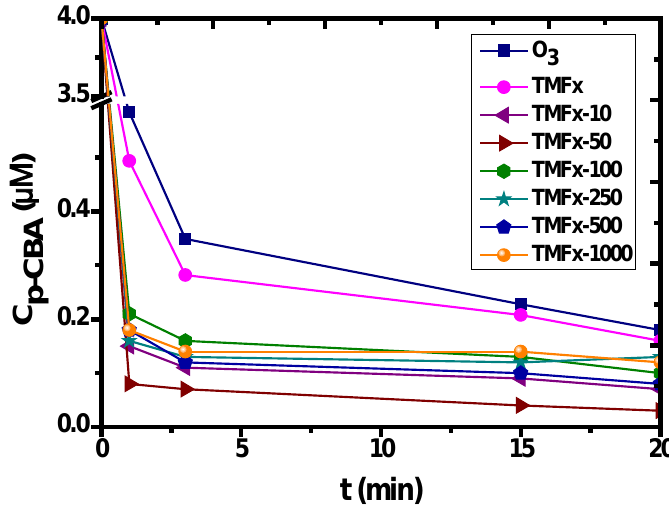
Figure 5. Influence of TMFx hydrophobicity to p‐CBA degradation in comparison with the single ozonation process; experimental conditions: C O ozonation process; experimental conditions: C O3 = 2 mg/L, C TMFx = 0.5 g/L, C p‐CBA = 4 μΜ, pH = 7, T = T = 20 ◦ 20 °C.